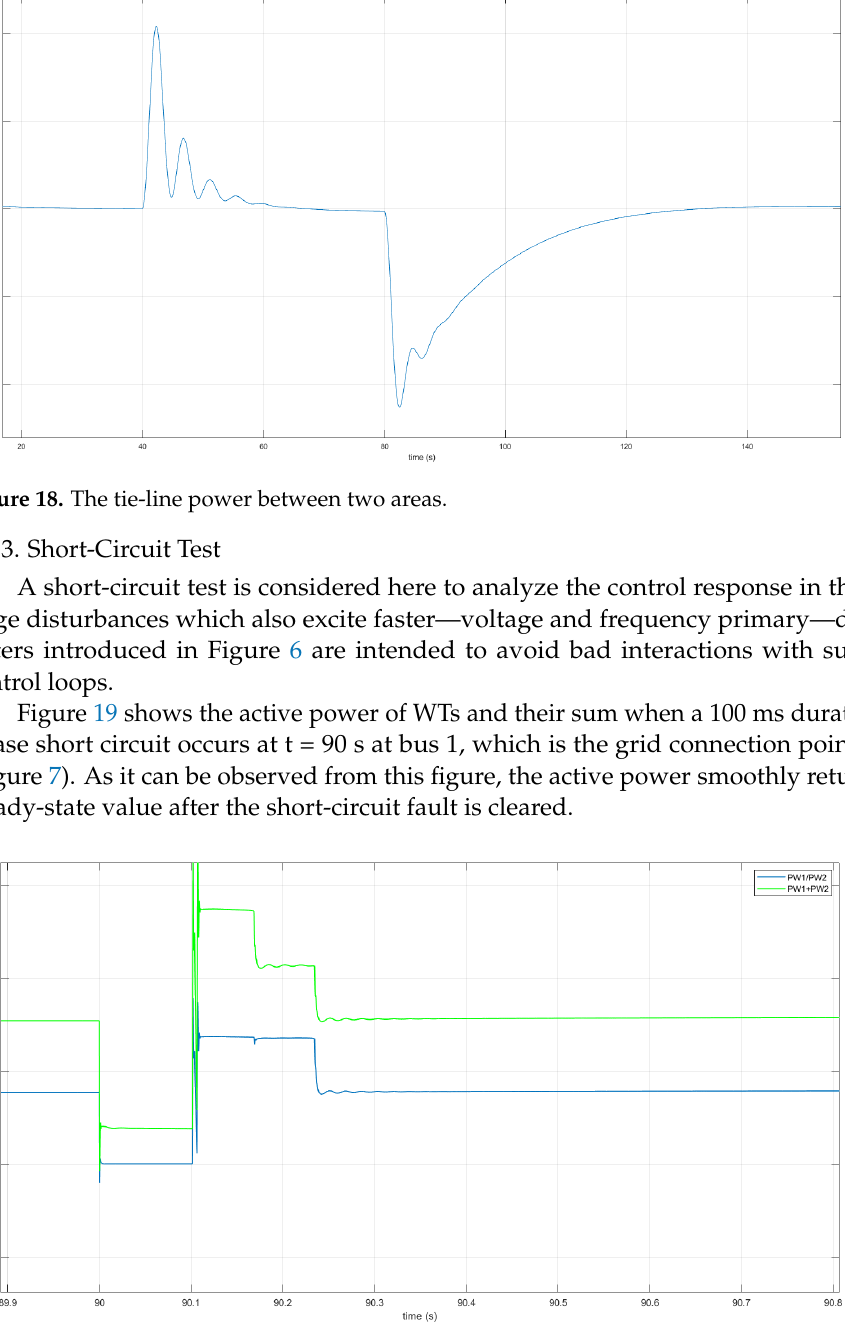
Figure 19. Active power of WTs and their sum in response to the three phase